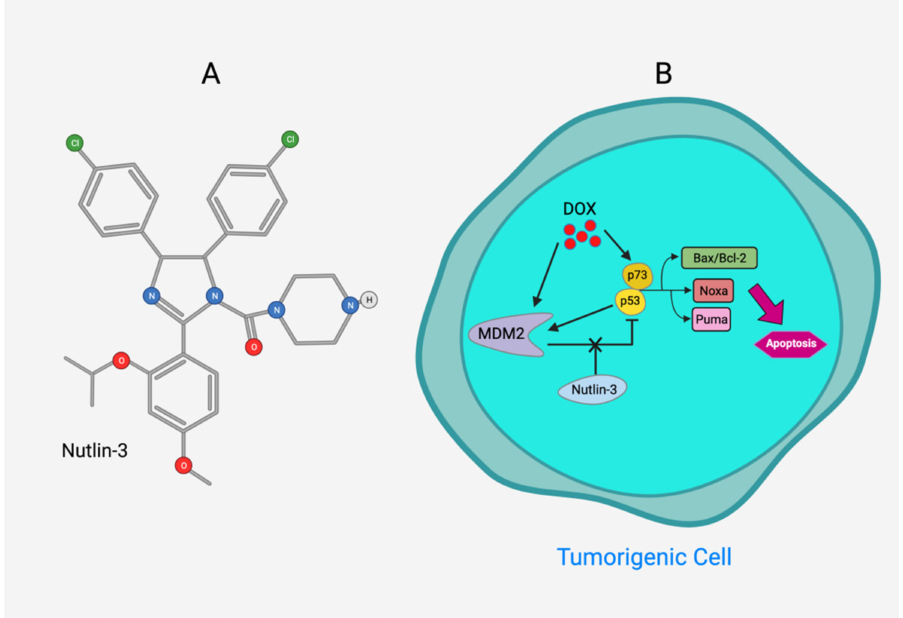
Figure 12. ( A ) Chemical structure of Nutlin-3. ( B ) Nutlin-3 inhibits binding of p53 and p73 to MDM2 when combined with DOX and increases p53 and p73 activity in human HCC cell lines (Modified from [109]).